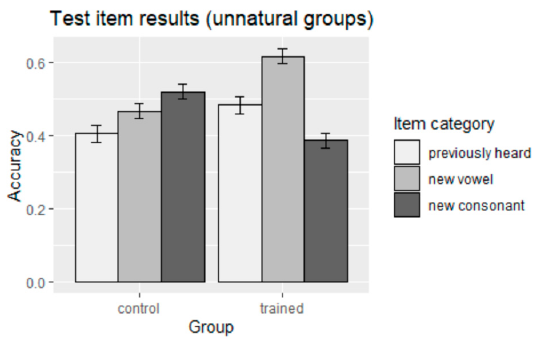
Figure 4. Accuracy of responses to test items (unnatural